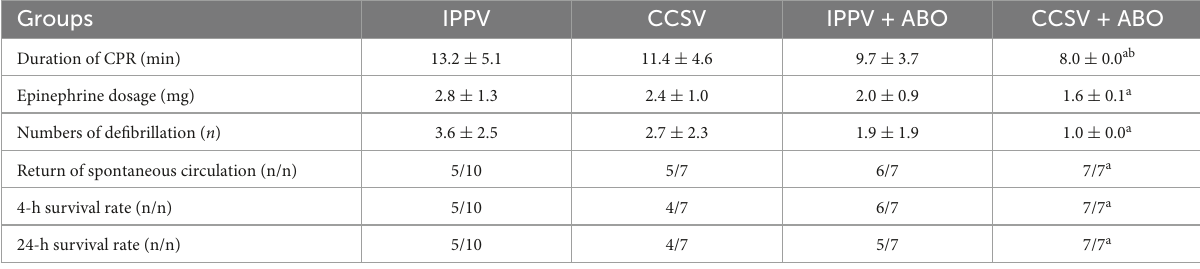
TABLE 3 Cardiopulmonary resuscitation outcomes and survival.